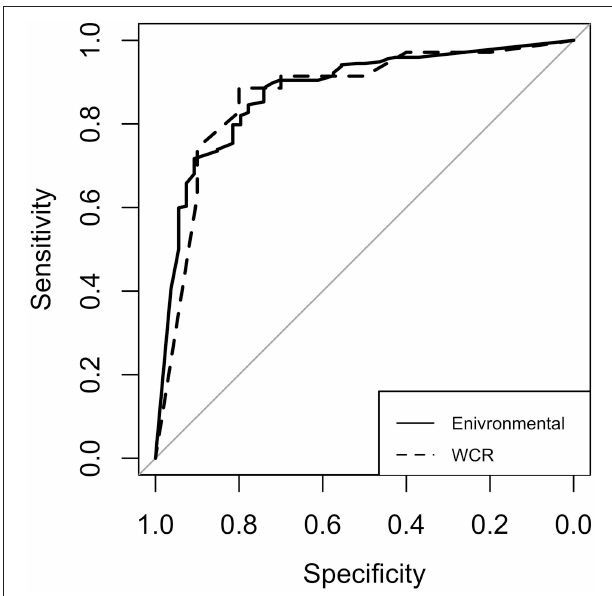
FIGURE 5 | Receiver operating characteristic (ROC) curves for the environmental (solid line) and whole carcass rinse (dashed line) random forest models. The diagonal line represents the line of no discrimination, or the expectation of a random guess. Curves above this line are considered better than random guess. The area under each curve is referred to as